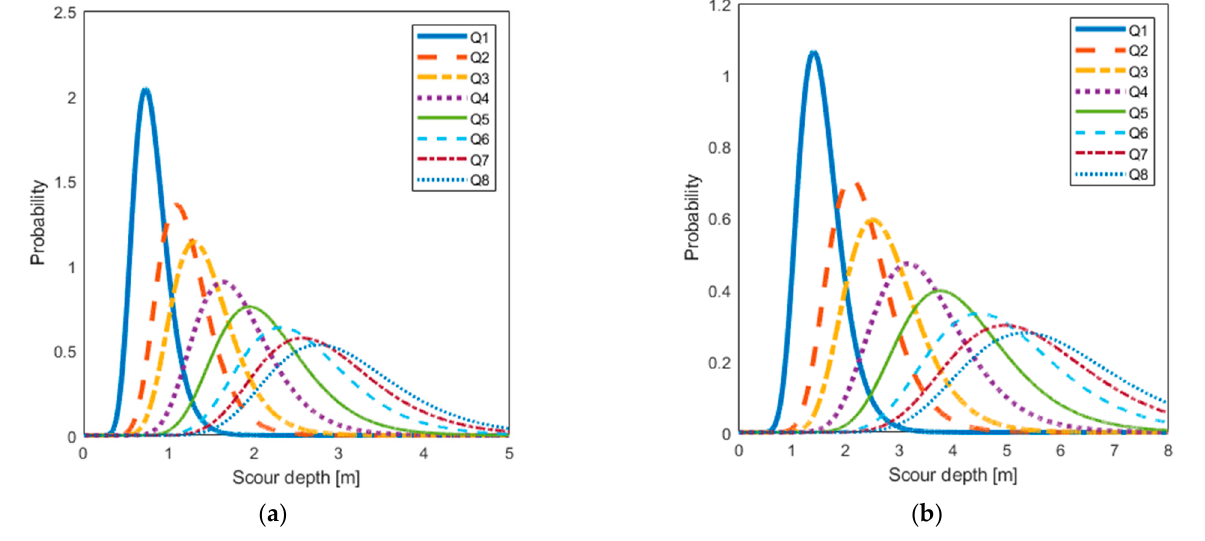
Figure 5. Fitted Gumbel distributions for the scour depth for each discharge value (Q1–Q8) for the cases with the value of the flow angle of attack of: ( a ) 0 ◦ (symmetric scour); ( b ) 20 ◦ (asymmetric